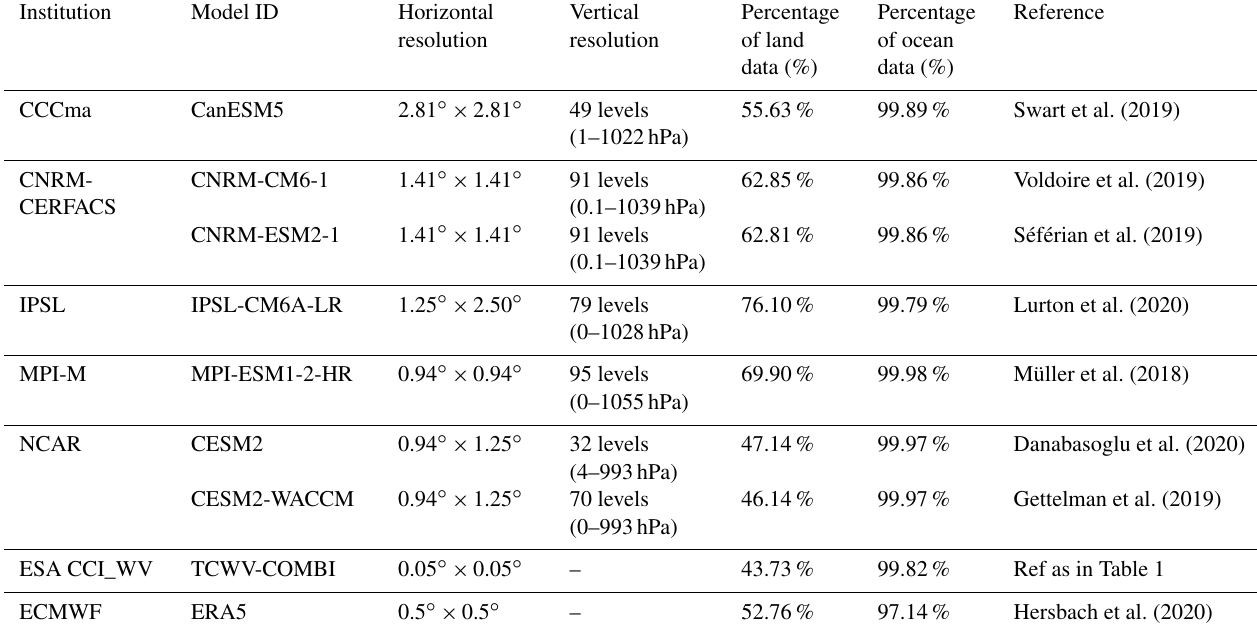
Table 2. Main characteristics of the seven CMIP6 models of the study, along with TCWV-COMBI and ERA5. The percentages over land and ocean are computed once the scene selection is